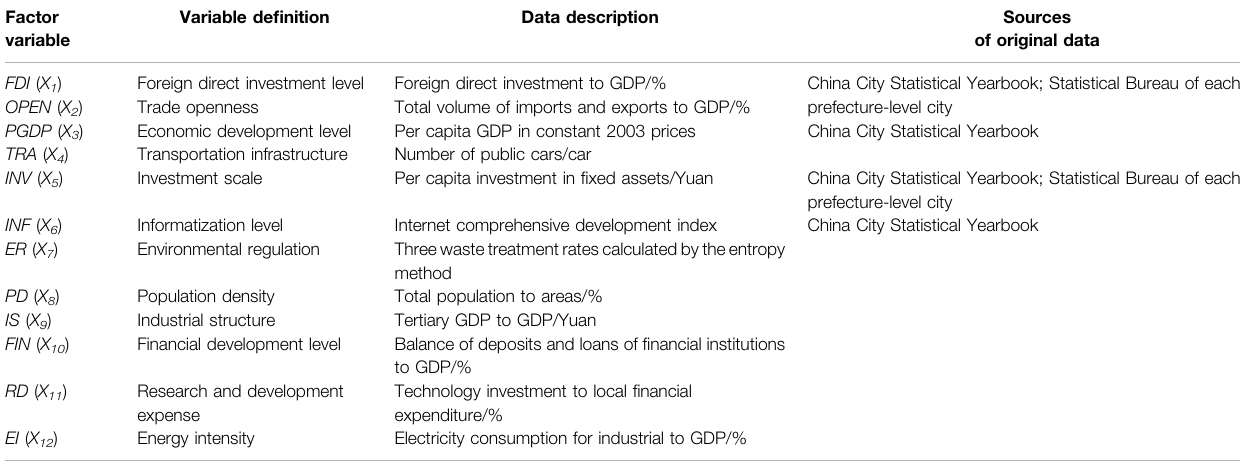
TABLE 1 | Description of the driving factors.